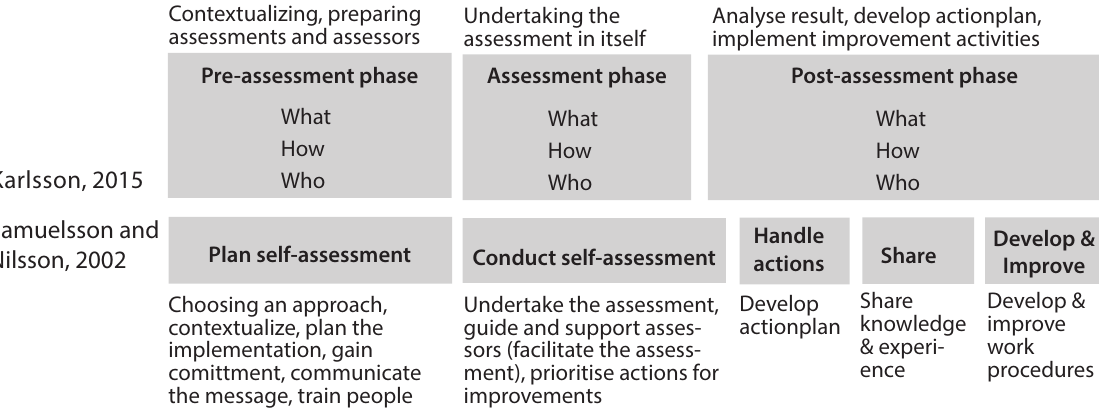
Fig. 1. This shows a comparison between the self-assessment processes as described by Samu- elsson & Nilsson (2002) and Karlsson